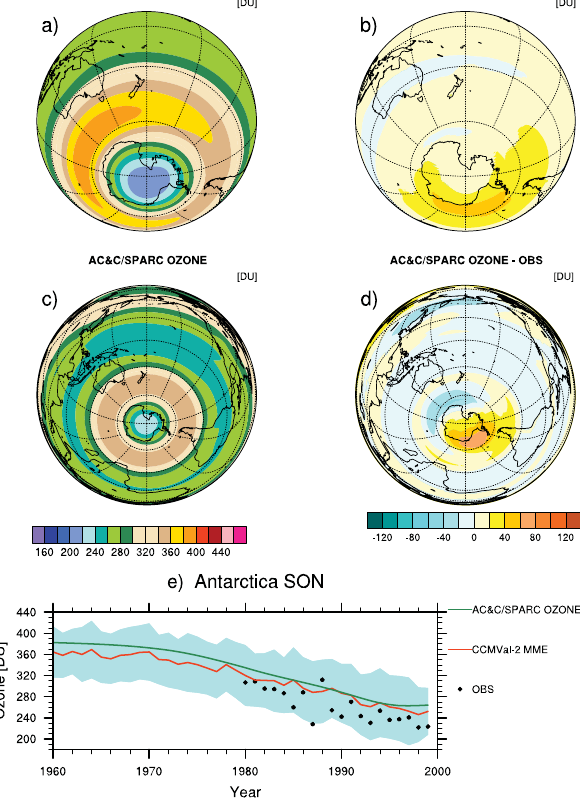
Fig. 6. September to November total column ozone mean (1980– 1999) from the CCMVal-2 multi-model mean (a) and the bias of it from the NIWA database (b) . (c, d) Same as (a, b) , but for the AC&C/SPARC ozone database; (e) time series of total column ozone over Antarctica (averaged from 60–90 ◦ S) from 1960 to 2000 for the CCMVal-2 multi-model mean (red line) and standard devia- tion (blue shaded area) in comparison to the AC&C/SPARC ozone database (green line) and observations from the NIWA database (black dots).